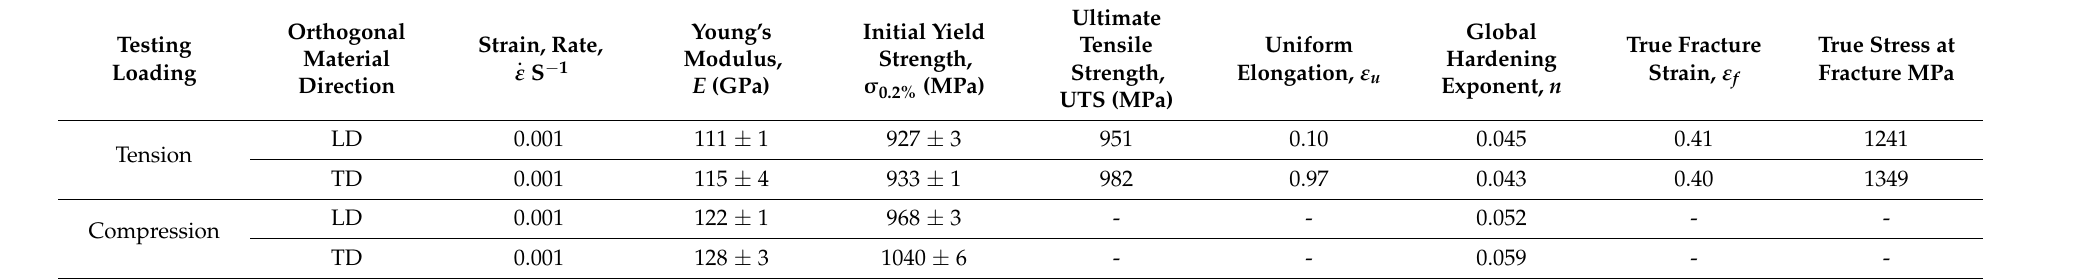
Table 2. Summary of the mechanical properties directly determined from the true stress–true strain curve presented in Figure